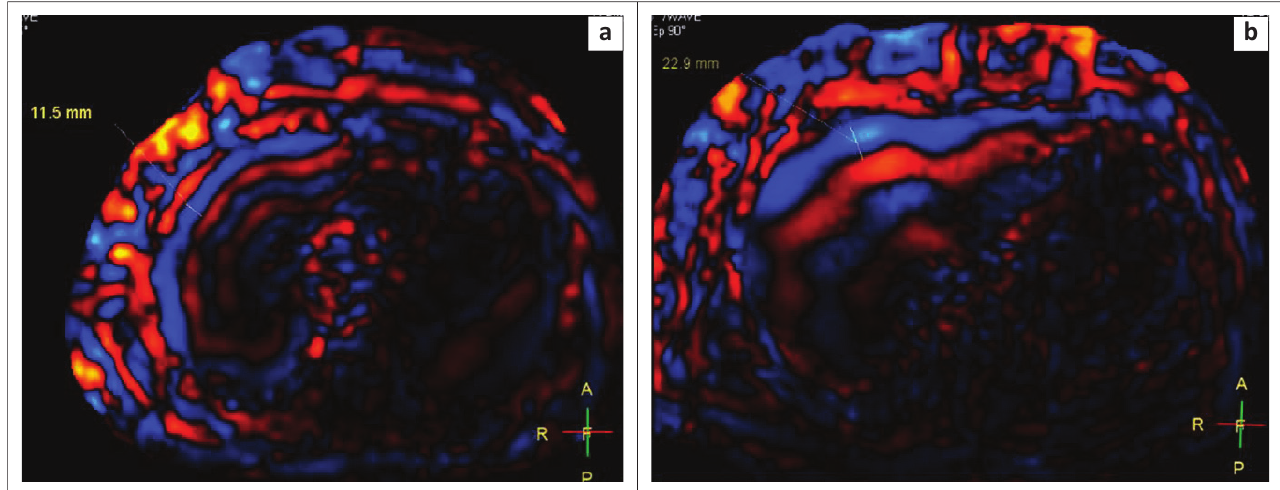
FIG URE 4: Wave images from a patient with normal liver stiffness measurement (a) and raised liver stiffness measurement (b) show an increase in the thickness of the waves (11.5 mm – 22.9 mm) as the liver stiffness measurement increases.